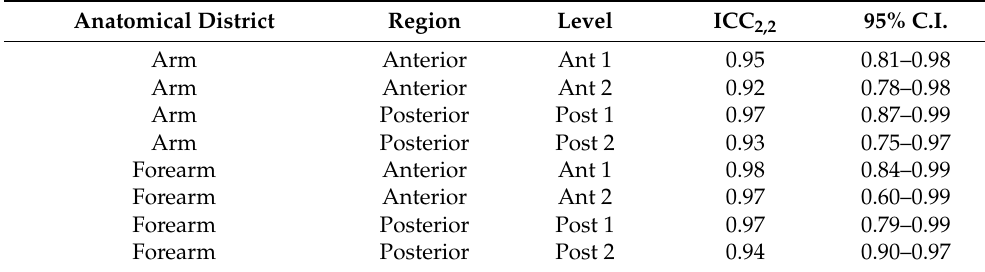
Table 10. Inter-rater reliability of the ultrasound measurements within different regions/levels of the deep fascia of the arm and forearm between the two